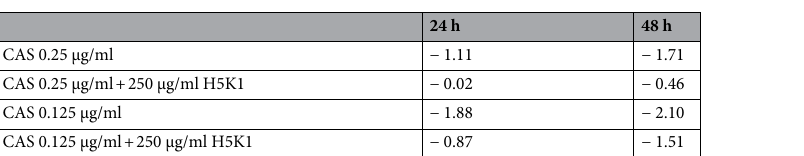
Table 6. ∆ log of the respective samples with the starting inoculum as evaluation of hmAb contribution in combination treatment .